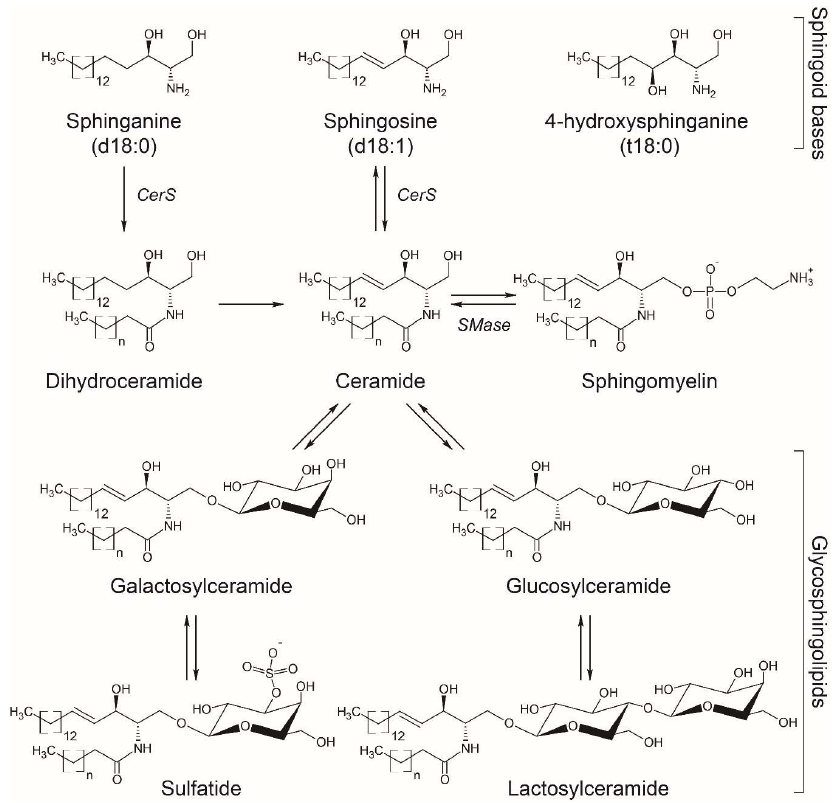
Figure 1. Basic structures of sphingoid bases and sphingolipids more commonly measured in biofluids. The arrows indicate the anabolic/catabolic flux, with some of the enzymes mentioned in the The arrows indicate the anabolic / catabolic flux, with some of the enzymes mentioned in the text indicated as follows: CerS, ceramide synthase; SMase,